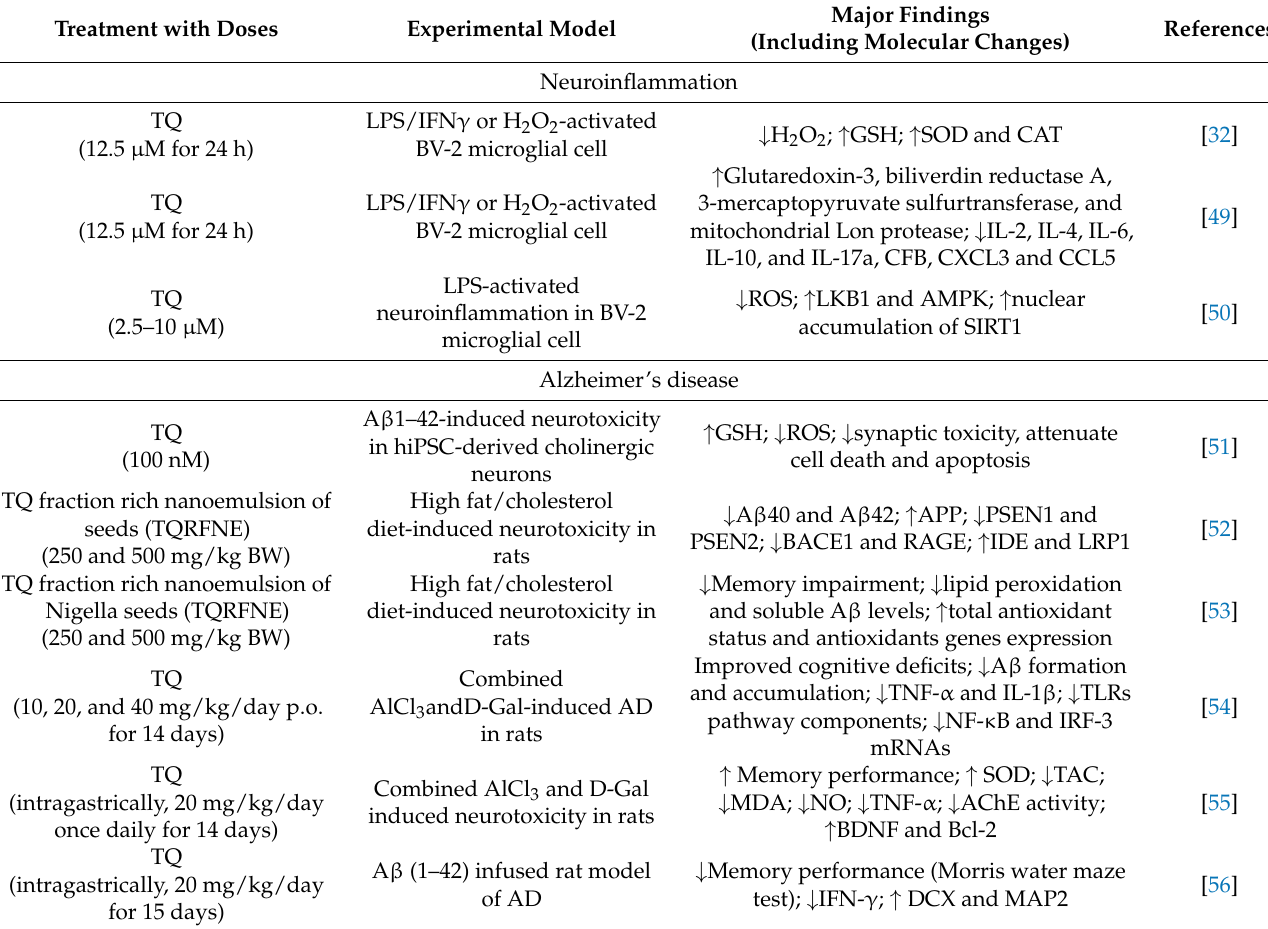
Table 1. Comprehensive summary on the protective effects of black cumin against neurological and mental problems. Treatment with Doses Experimental